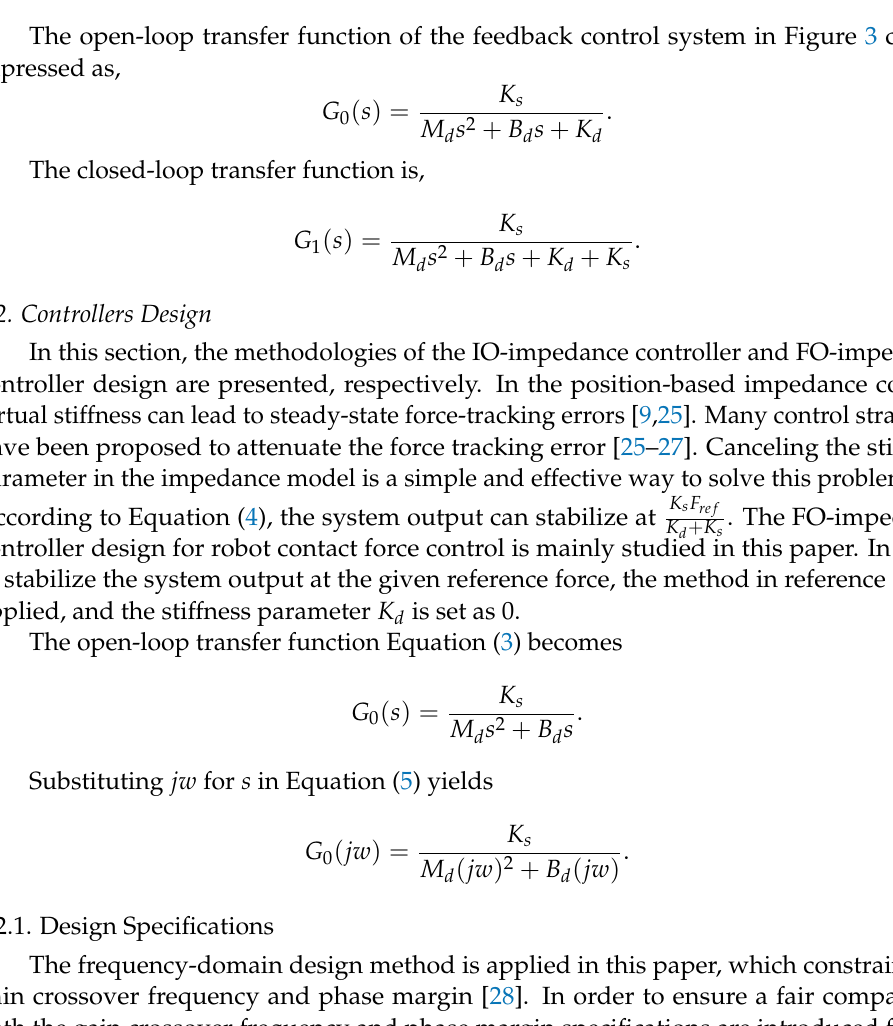
Figure 3. Simplified robot manipulator impedance-control system